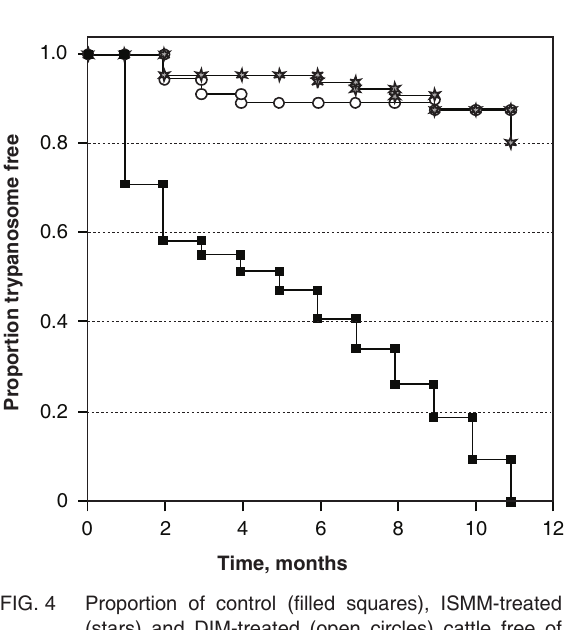
FIG. 2 Proportion of control (filled squares), ISMM-treated (stars) and DIM-treated (open circles) cattle free of T. congolense infections under a suppressed tsetse pop- ulation in southeast Uganda